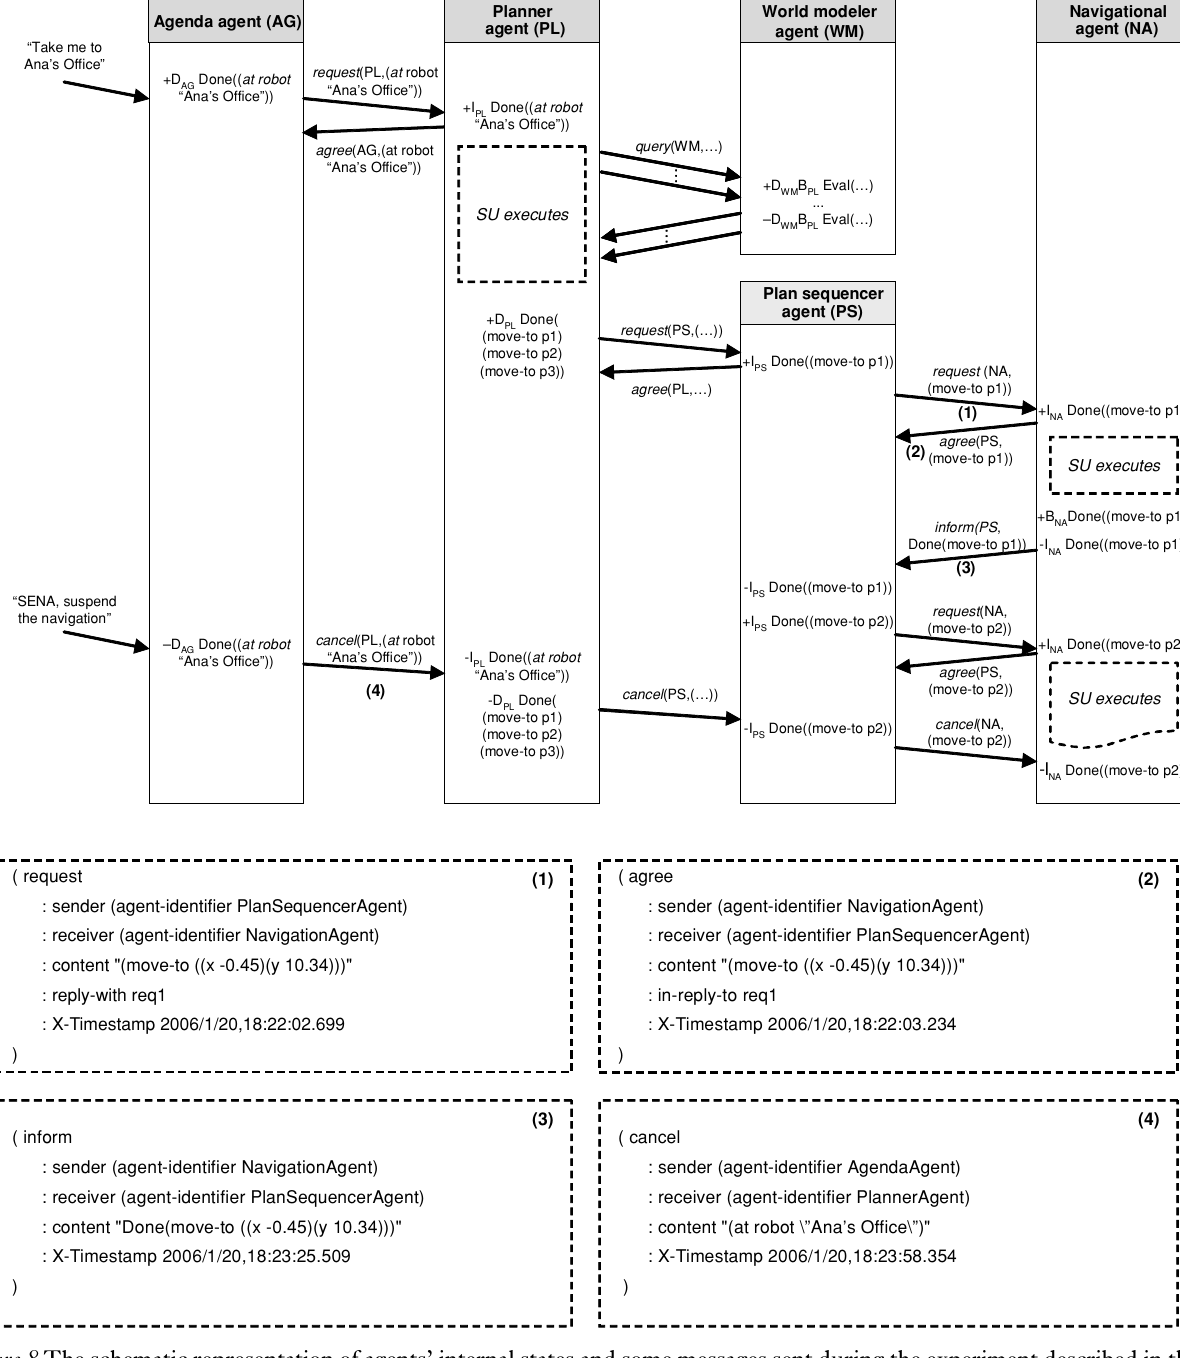
Figure 8 The schematic representation of agents’ internal states and some messages sent during the experiment described in the